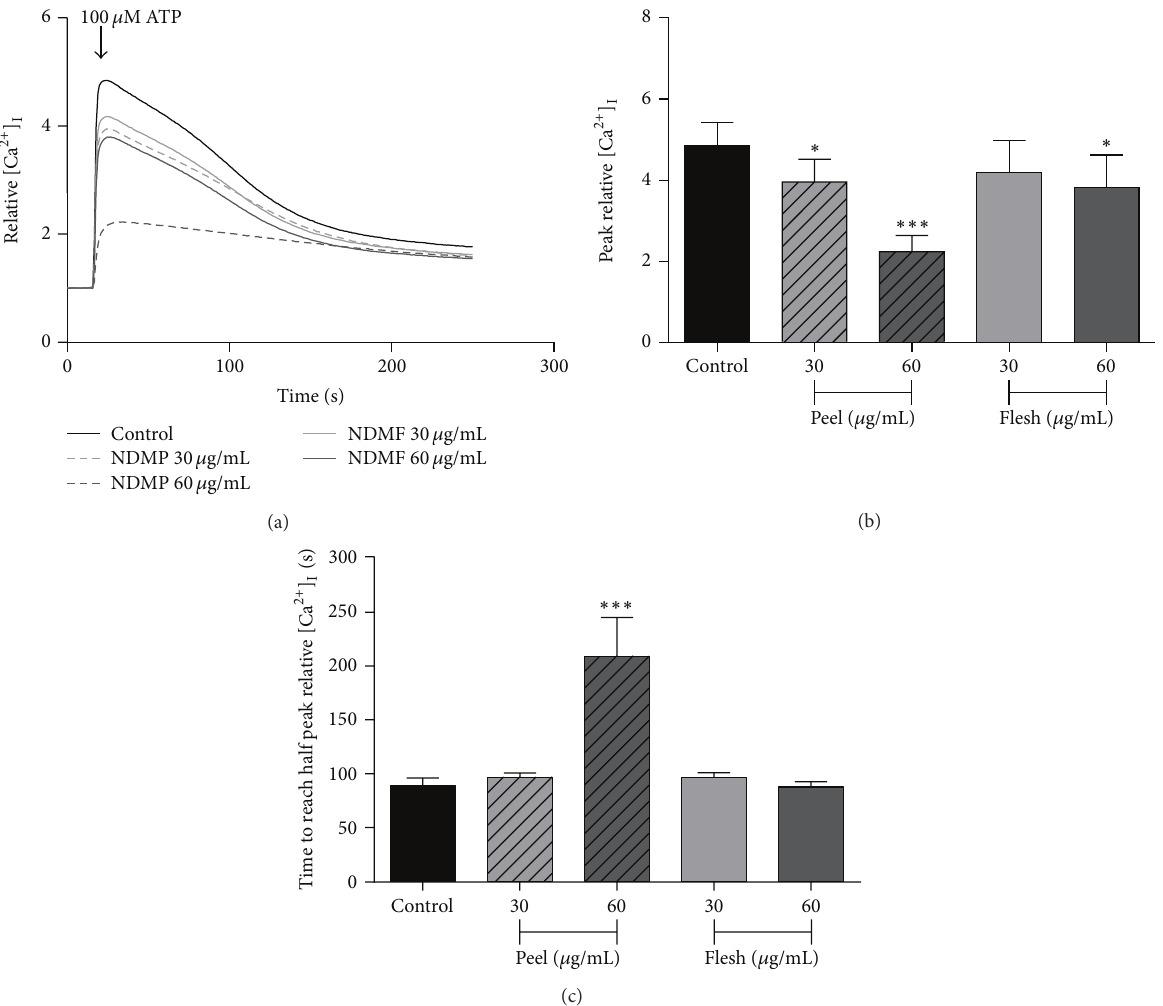
Figure 4: (a) Average relative [ Ca 2+ ] transients, (b) peak relative [ Ca 2+ ] response, and (c) time to reach half peak relative [ Ca 2+ ] I I cells treated with NDM peel (P) and flesh (F) extracts for 96h and stimulated with ATP (100 𝜇 M). Cells were loaded with Fluo-4 AM dye; was measured using FLIPR TETRA and represented as response over baseline. Trace, mean ( 𝑛 = 9 ). Columns, means ( 𝑛 = 9 ) ± relative [ Ca 2+ ] I S.D. ∗ 𝑃 ≤ 0.05 . ∗∗ 𝑃 ≤ 0.01 . ∗∗∗ 𝑃 ≤ 0.001